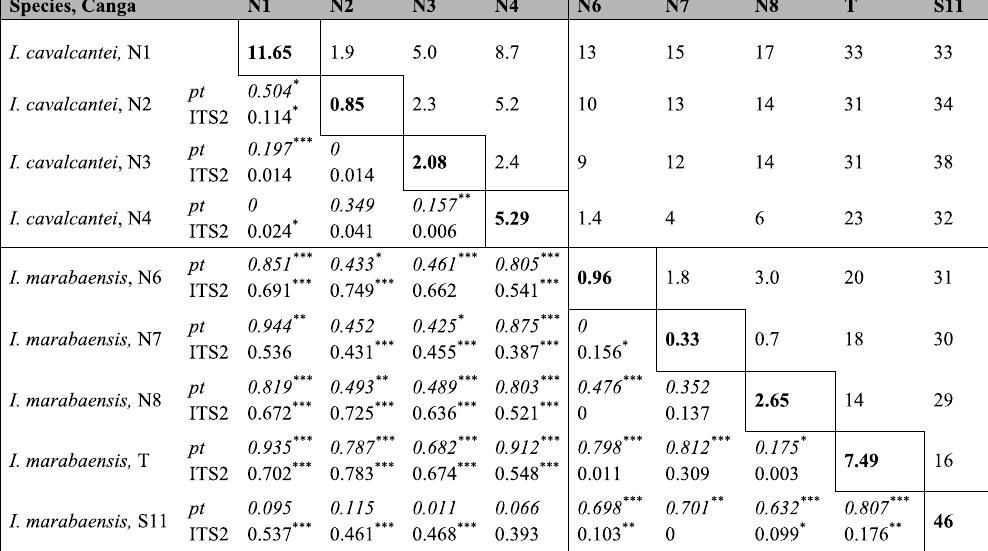
Table 1. Canga areas, geographic distances and genetic differentiation of I . cavalcantei and I . marabaensis populations. The values along diagonal (in bold) are areas of Cangas (km 2 ). Values above diagonal are the shortest distances between Canga islands (km). The pairwise genetic differentiation measured by the population descriptive statistics is shown below the diagonal. The F ST values from the plastome ( pt ) gene alleles, emphasized by italics font, and internal transcribed rDNA spacer alleles (ITS2) are combined in the same cells. Asterisk are the p values: * < 0.05; ** < 0.01; *** <